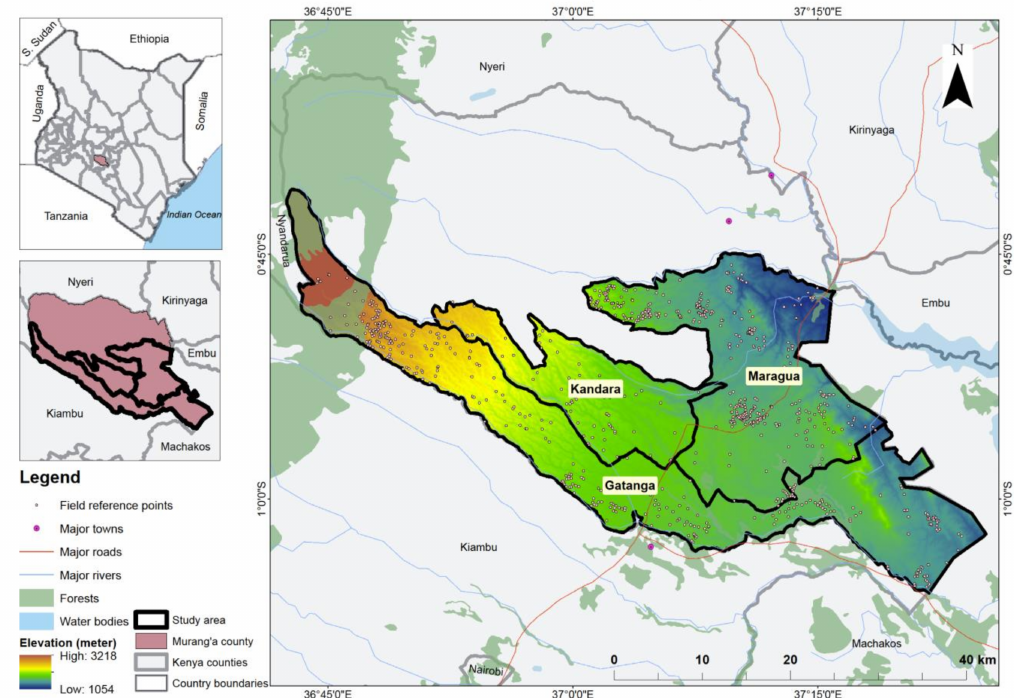
Figure 1. Location of the study area comprising the three sub-counties, i.e., Kandara, Maragua, and Gatanga, in Murang’a County, Kenya with overlaid field reference points and surface features. The background layer shows the elevation across the study area that was generated from the shuttle radar topography mission of 30 m spatial